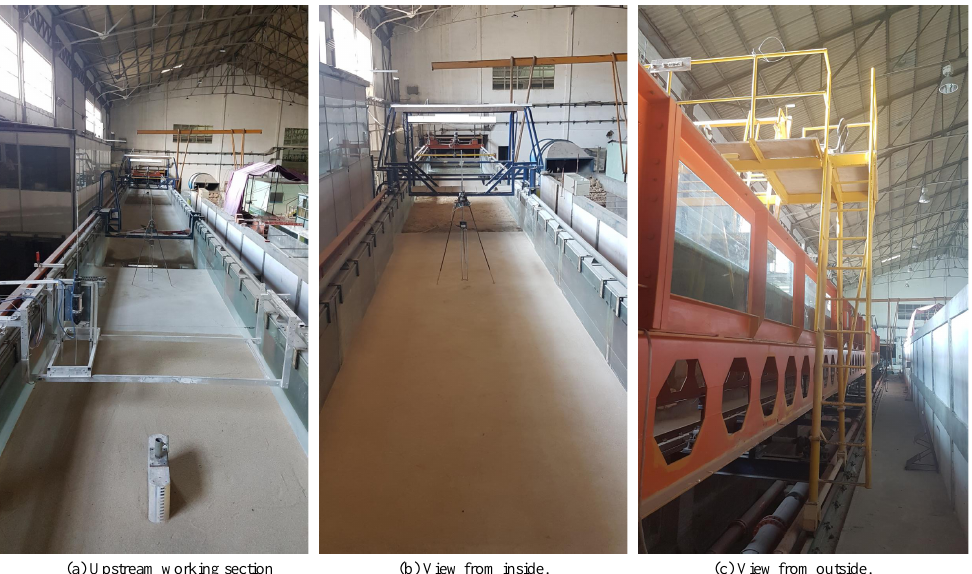
Figure 1. Experimental facility and bridge pier